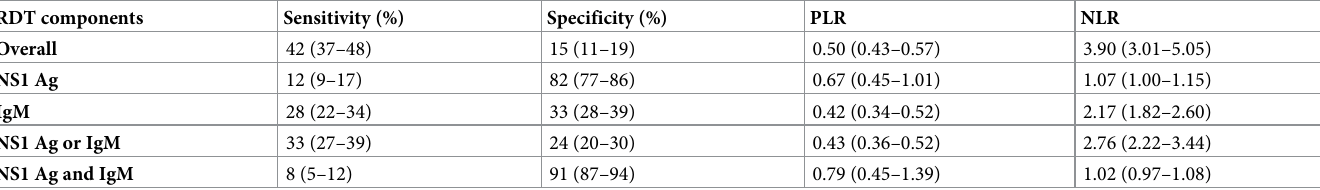
Table 2. Performance of SD Bioline Dengue Duo rapid diagnostic test, Reunion, 2019 (N = 671). RDT components